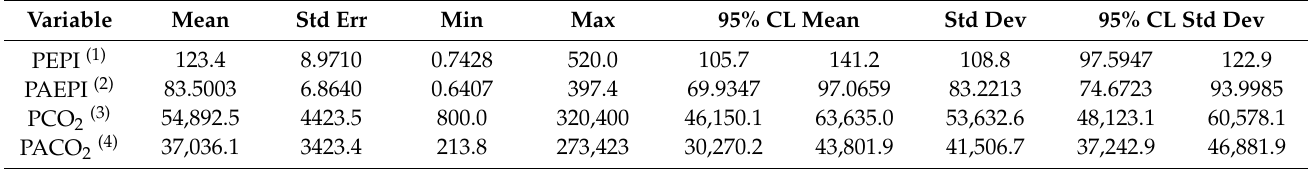
Table 5. T -test results with a confidence interval of 95% for the energy performance index (EPI) and CO 2 emissions for both pre-audit and post-audit